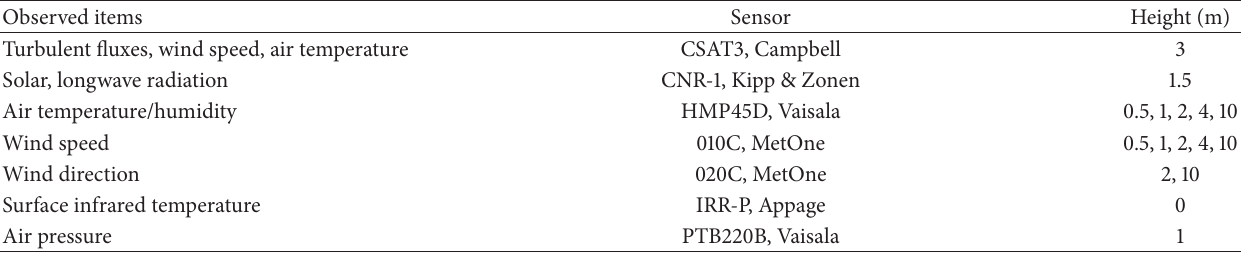
Table 2: Observational instrumentation a